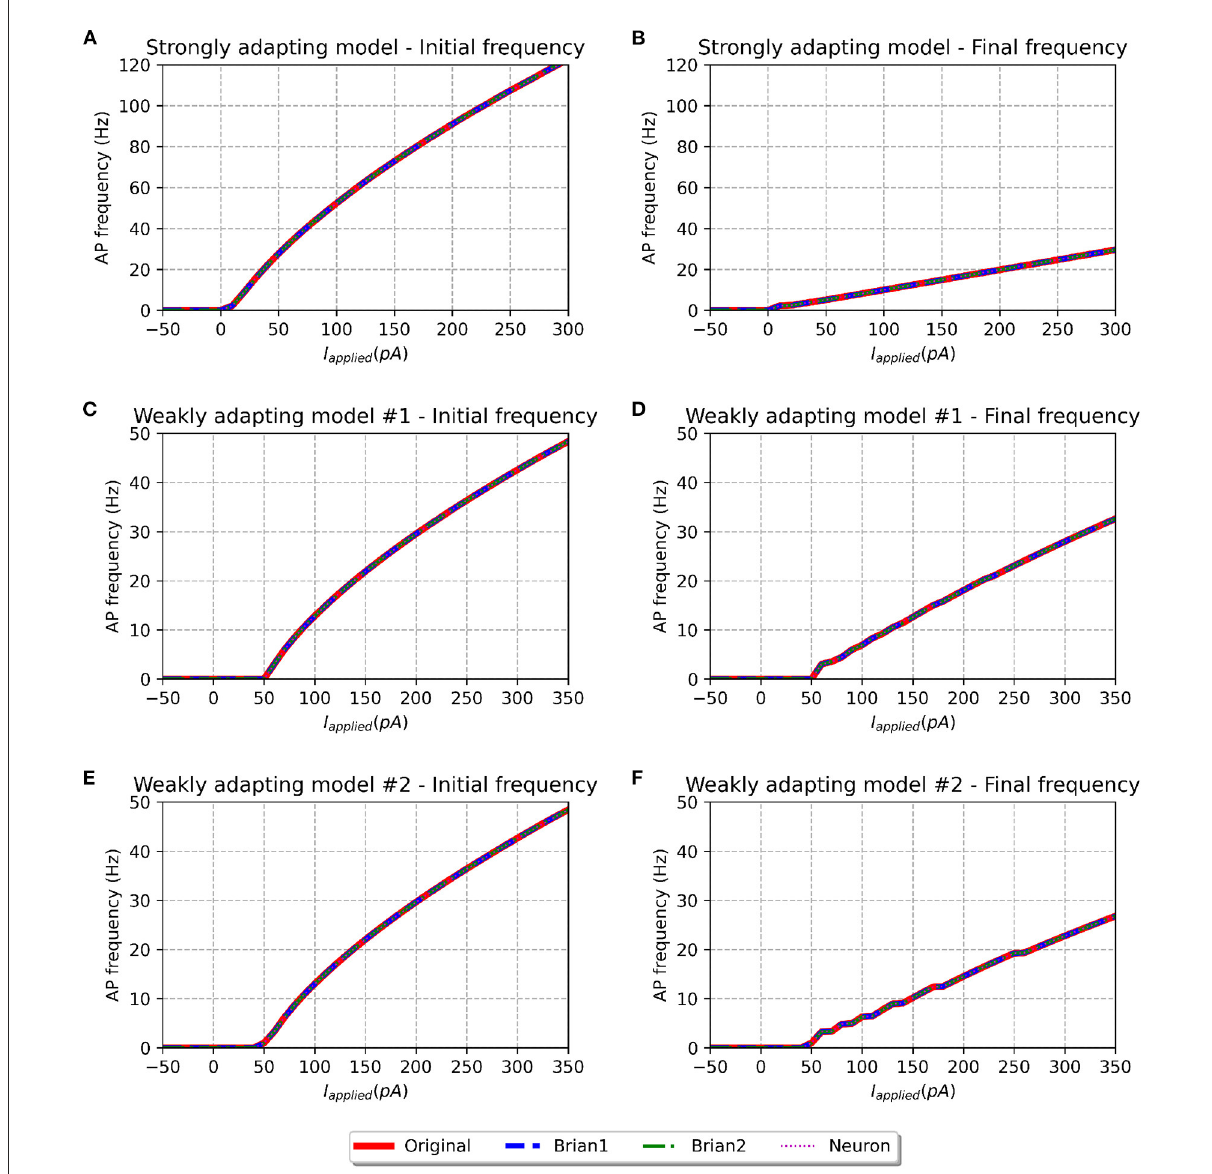
FIGURE4 f-I curve for the various models when run with initial membrane potential set to − 65 mV. Panels on the left show the initial f-I curve, while those on the right show the final f-I curve. The variation in spiking frequency, difference between initial and final f-I curves, is very noticeable for the strongly adapting models, and comparatively much lower for the weakly adapting cells. All the model implementations show near-identical